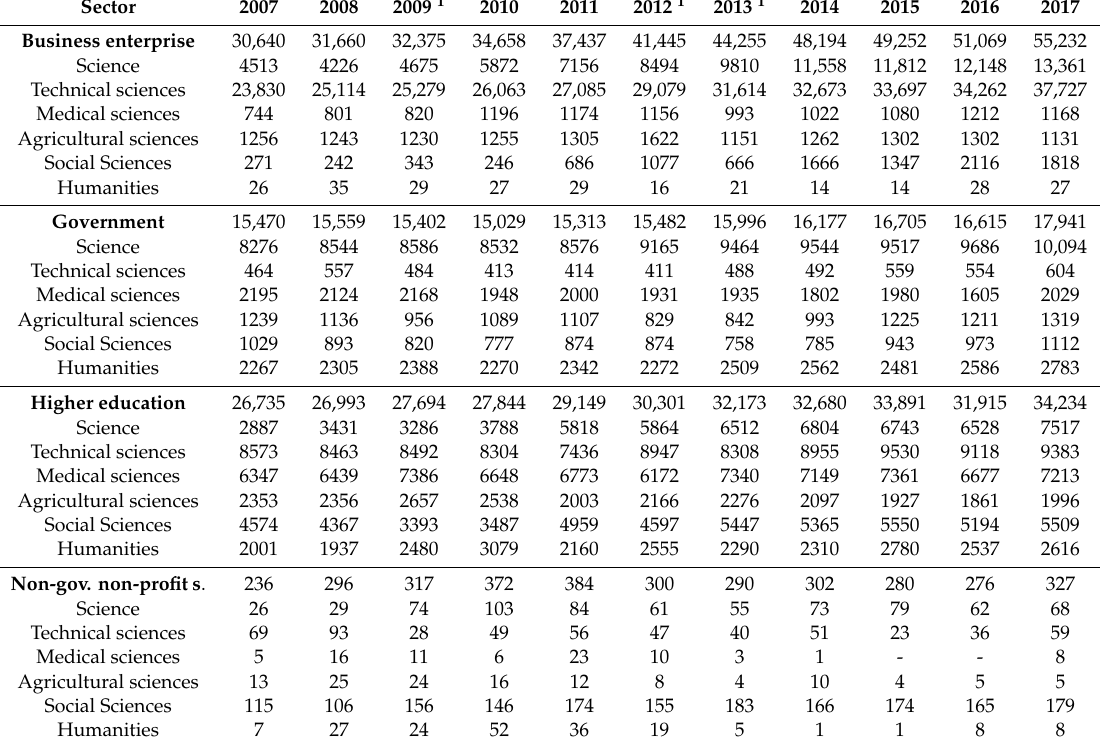
Table 8. R&D personnel by sector of the Czech Republic by fields of science 2007–2017